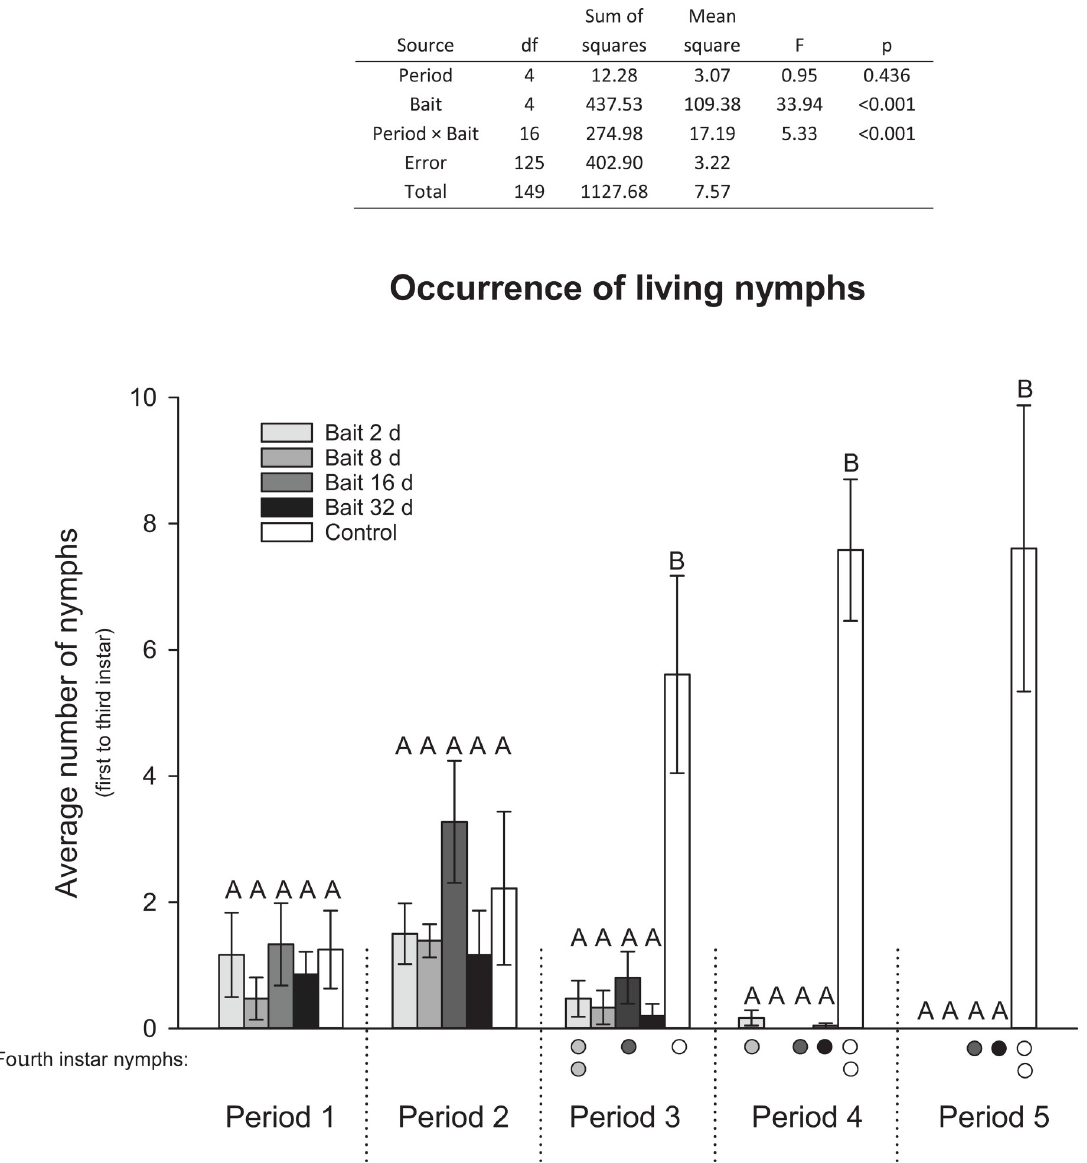
Fig 8. Average number of living Ctenolepisma longicaudatum nymphs (1 st to 3 rd instar) per population box (with 12 adults and 12 nymphs each) in different bait treatments at different periods. The table presents the two-way ANOVA that describes the effect of the two predictor variables: Period and Bait (number of days with bait present). Different letters (A and B) in the figure indicate significant differences between bait treatments within periods (Holm–Sidak, p < 0.05). Coloured dots below the x-axis indicate the number of 4 th instar nymphs that were present in the respective